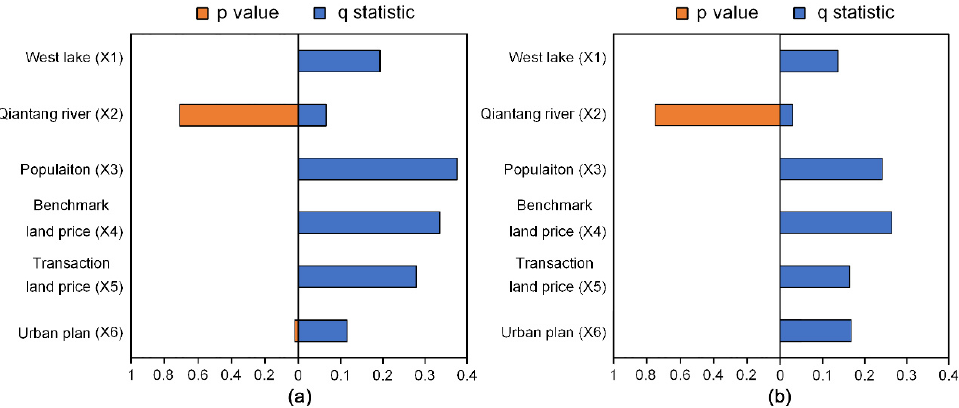
Figure 6. The q -statistic and p value calculated by factor detector: ( a ) Factor Detector results of residential sprawl in 2000; ( b ) Factor Detector results of residential sprawl in 2010.